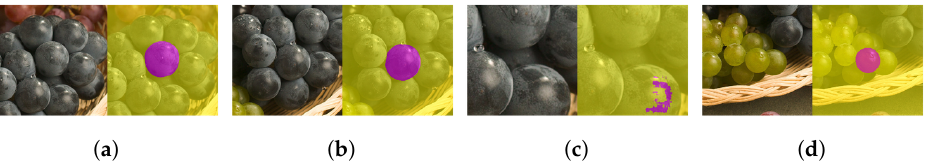
Figure 6. Identifying the central grapes in the bunch of grapes. ( a ) The central grape is identified. ( b ) The central grape in another frame is identified. ( c ) CROP is confused because there is no central fruit in front. ( d ) The central object can be small, and may not have to be salient. The original photo is credited to USDA ARS (Peggy Greb).